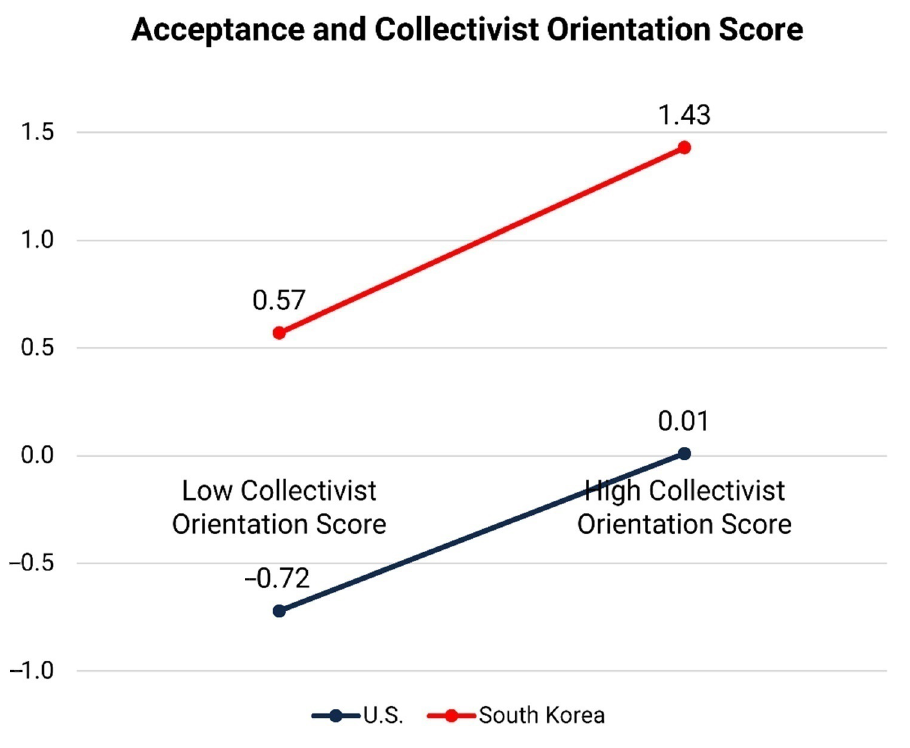
Figure 7. Average combined acceptance score (standardized) of people with low levels of collectivist orientation scores and high levels of collectivist orientation scores.